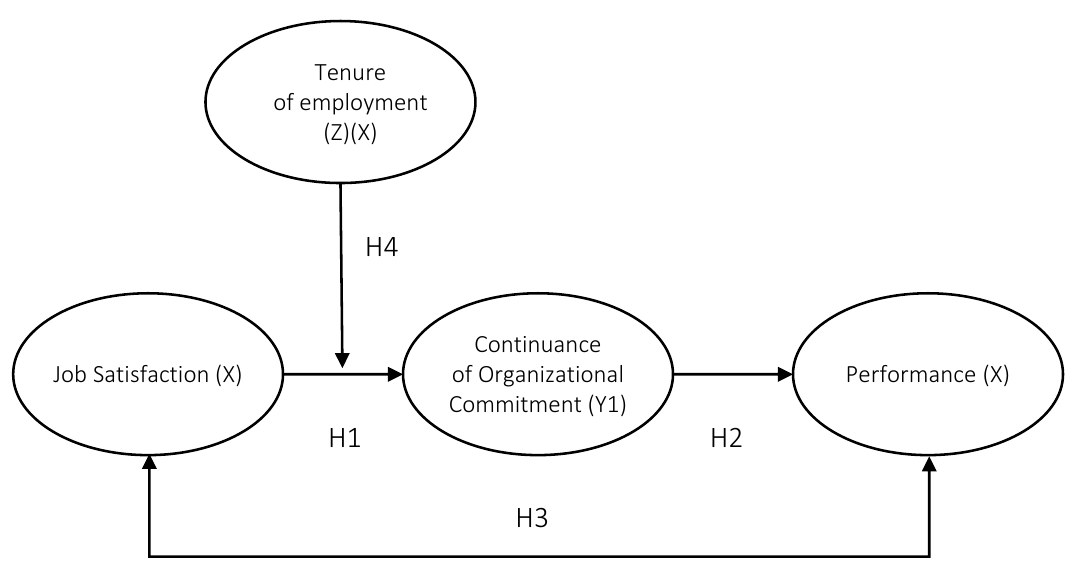
Figure 1. Conceptual